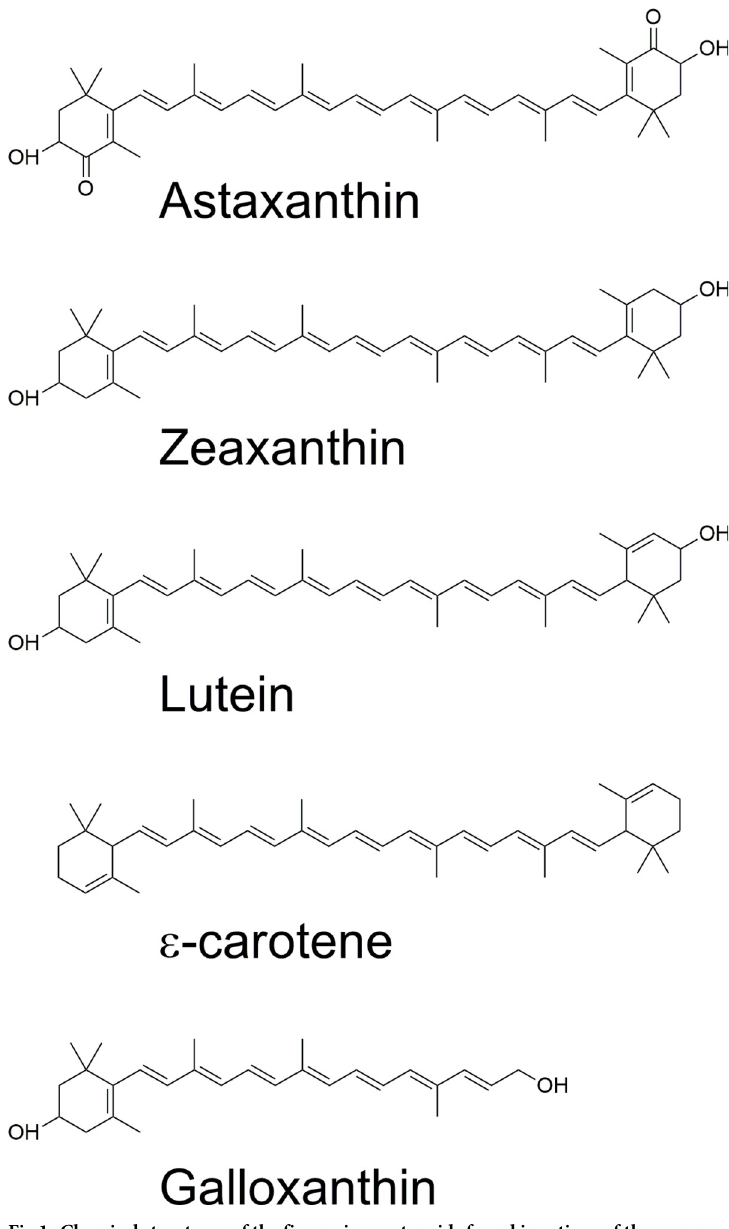
Fig 1. Chemical structures of the five main carotenoids found in retinas of the common